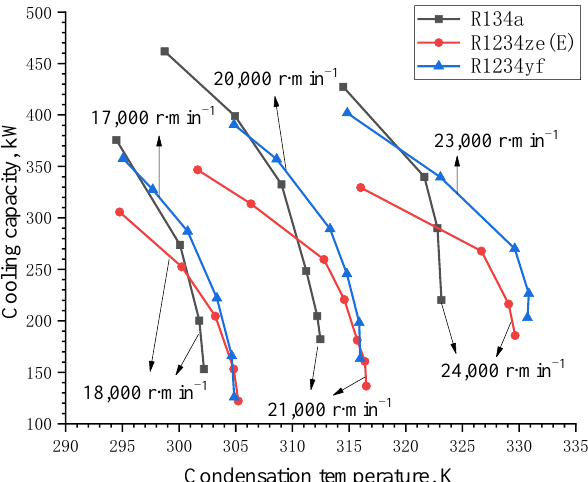
Figure 9. Performance curve of centrifugal compressor: ( a ) Mass flow rate-pressure ratio perfor- mance curve; ( b ) Mass flow rate-power performance curve; ( c ) Mass flow rate-efficiency perfor- mance curve.